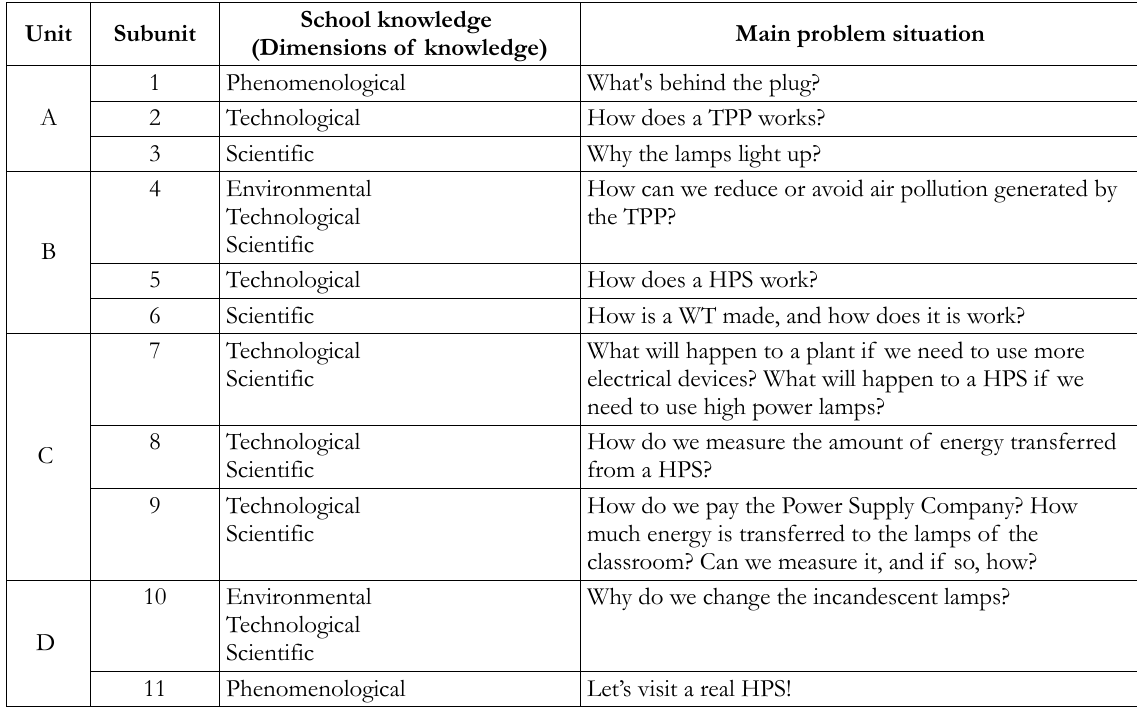
Table 1. The structure and content of the teaching